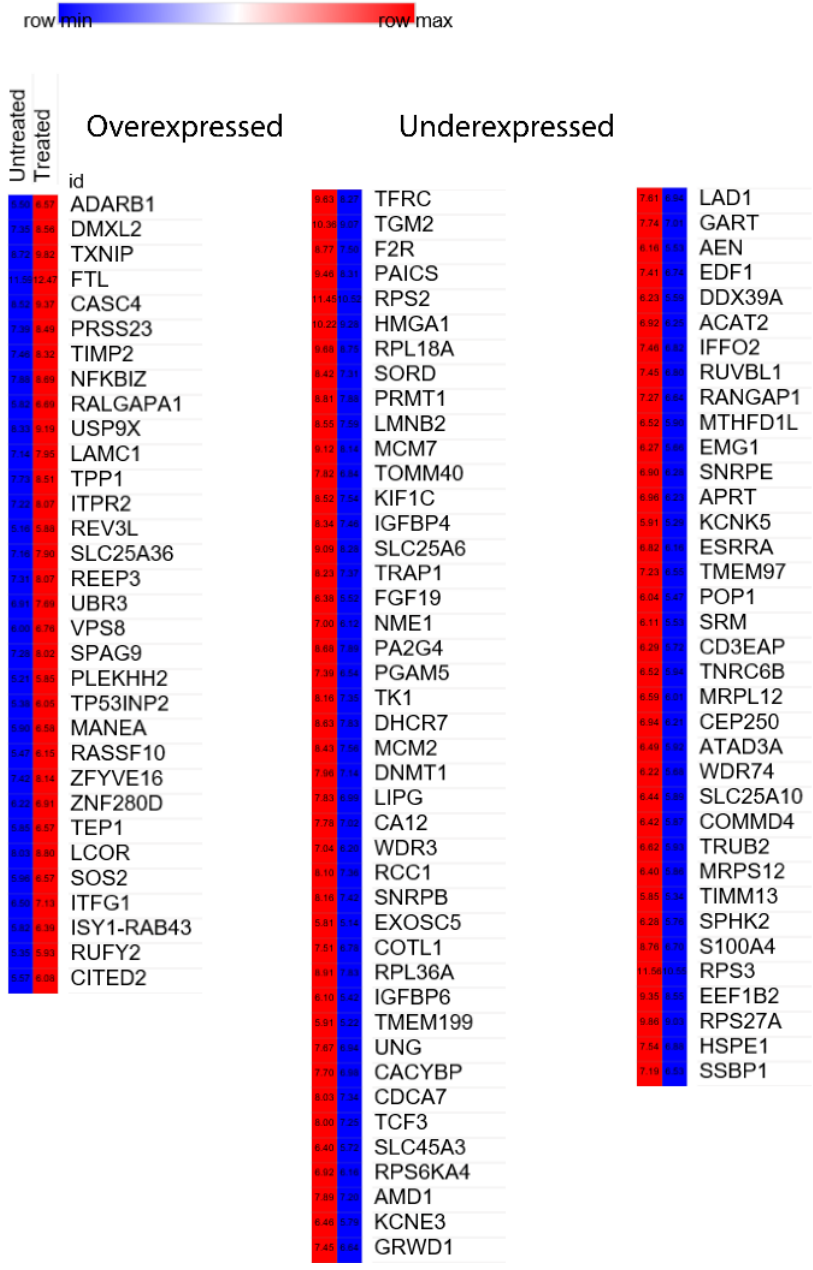
Figure 3. Heatmap of differentially expressed genes between the CPT-CEF-treated and untreated HT29 colon cancer cells. The differentially expressed genes involved in epigenetic mechanisms were measured using DESeq2 and categorized based on underexpression and overexpression ( p < 0.05, fold change > ± 2.0). Genes from the most over-represented H3K56ac epigenetic modifications were extracted and